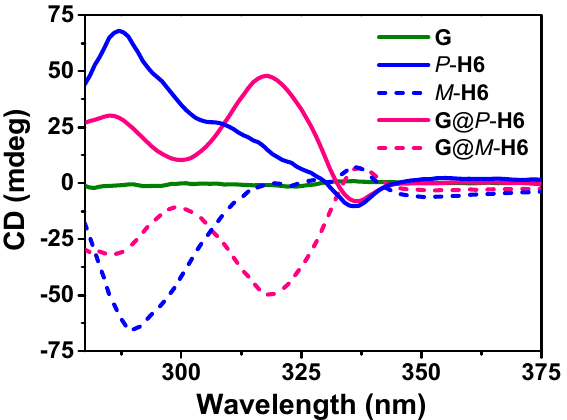
Figure 8. The CD spectra of P / M - H6 hosts, silver cluster G , and nanocluster complexes G @ P / M - H6 in the solid state. in the solid